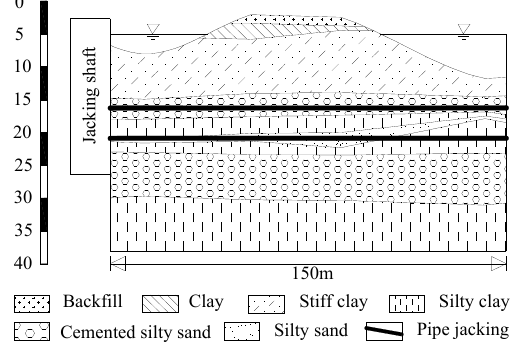
Figure 7. Distribution of soil layers in construction site.